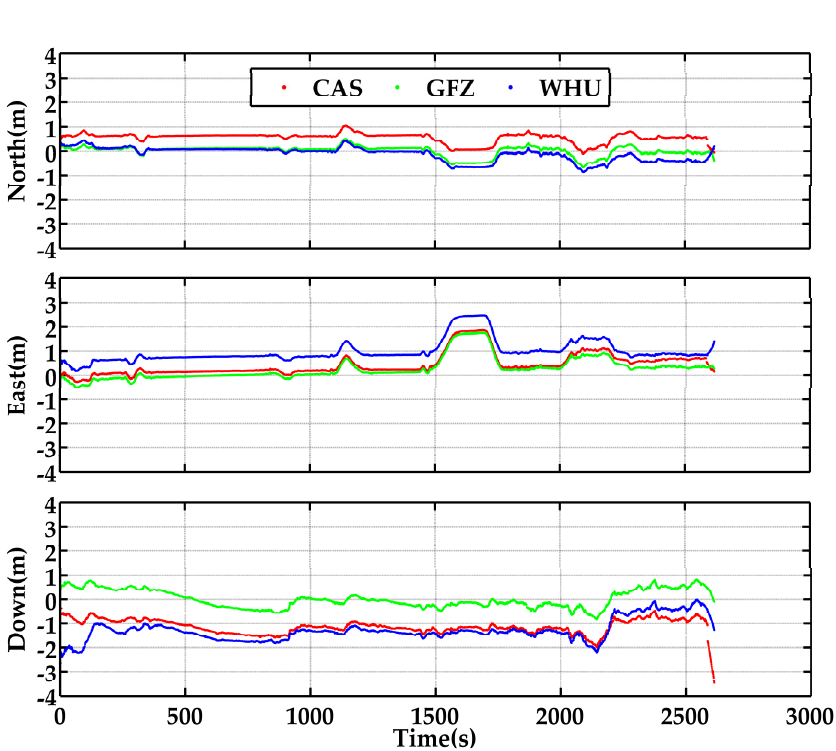
Figure 8. Position differences of G + B SF-PPP/INS tight integration in the three directions using the real-time products from CAS, GFZ, and WHU (the start time is 195,453 s).